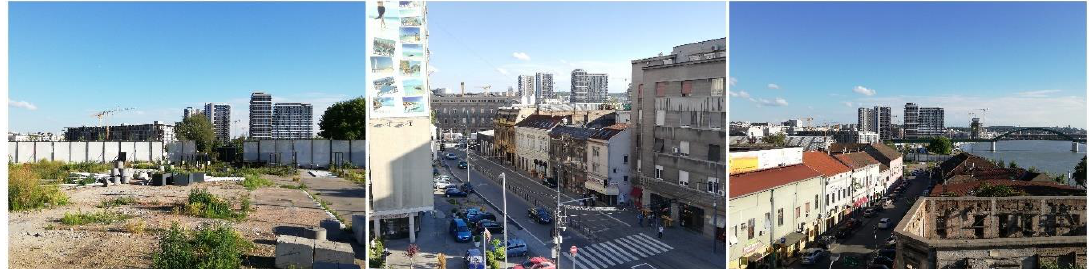
Figure 7. The Savamala neighbourhood and the Belgrade Waterfront that rises above in 2020 (source: author’s collection, June 2020).